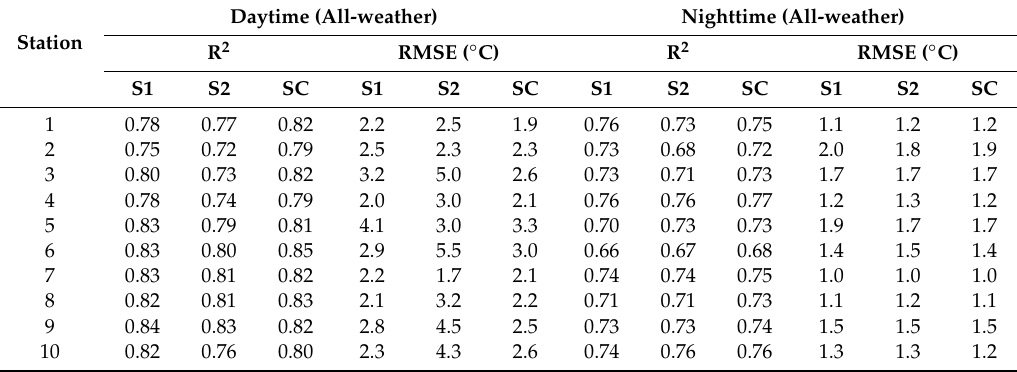
Table 5. The leave one-station out cross-validation (LOOCV) results of the estimated 1 km all-weather LSTs from scheme 1(S1), scheme 2(S2) and scheme combined (SC) using 1 km bias-corrected in situ LSTs at 10 stations during July and August from 2013 to 2018 for daytime. Refer to Figure 1 for station numbers. Daytime Station